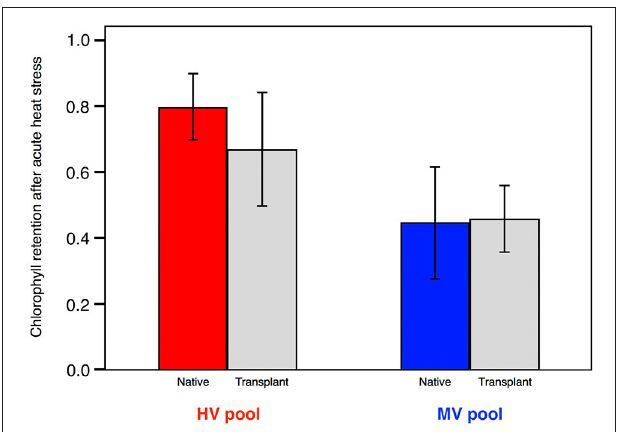
FIGURE 2 | Thermal tolerance, measured as chlorophyll retention following acute heat stress, in A. hyacinthus following 14 months of reciprocal transplantation between the HV and MV